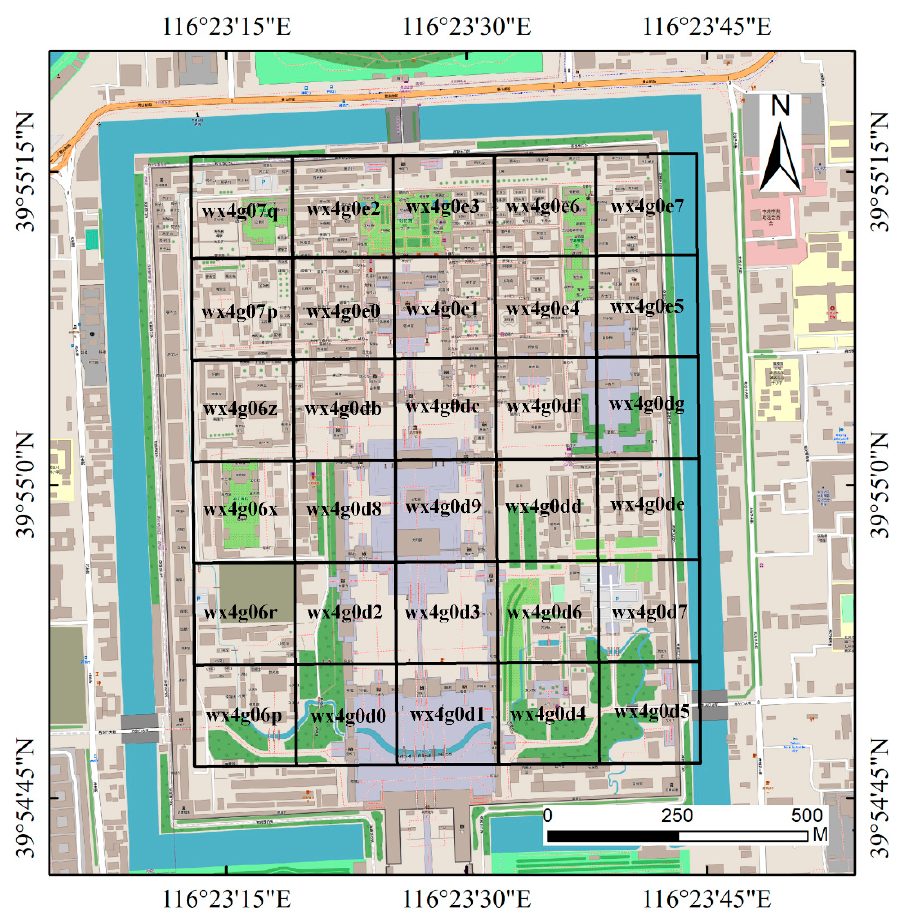
Figure 2. Example of Geohash7 grids in the central parts of the study area. Note that the mobile devices were sampled through the embedded SDK, namely, not all the devices were acquired and reported for a given moment within the given Geohash grid (generally at a low sample rate to save mobile device power under normal condi- tions). To improve the sample rates, the MS data were accumulated at an interval of an hour. Thus, the same devices may have been sampled more than once at the same Geo- hash grid or sampled at different grids during the one-hour time range. To reduce dupli- cate samples, data cleaning was performed. As the data reported by SDK included some private information, such as phone numbers, after data cleaning, the data were anony- mous and could be delivered to the users. The MS data were accumulated over an hour because the BFT was estimated based on the diurnal variation in the MS data. If the tem- poral resolution was too coarse, the variation differences between different BFTs could not be detected by means of MS data. Considering the obvious differences in human dynamics between weekdays and weekends, two days of MS data from the study area in Beijing in 2020 were collected: 9 December 2020 (Wednesday) and 12 December 2020 (Saturday). Four types of MS indica- tors were provided by GeTui and used in this study: (1) Station Station represents the number of active communication base stations that can be scanned by the mobile devices in each Geohash grid per hour. Mobile devices regularly report information on scanned base stations, and base stations within a specified geo- graphical area are acquired based on the base station beacon location database.